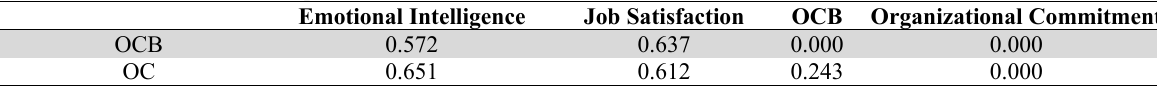
Standardized Total Effects (Group number 1 – Default